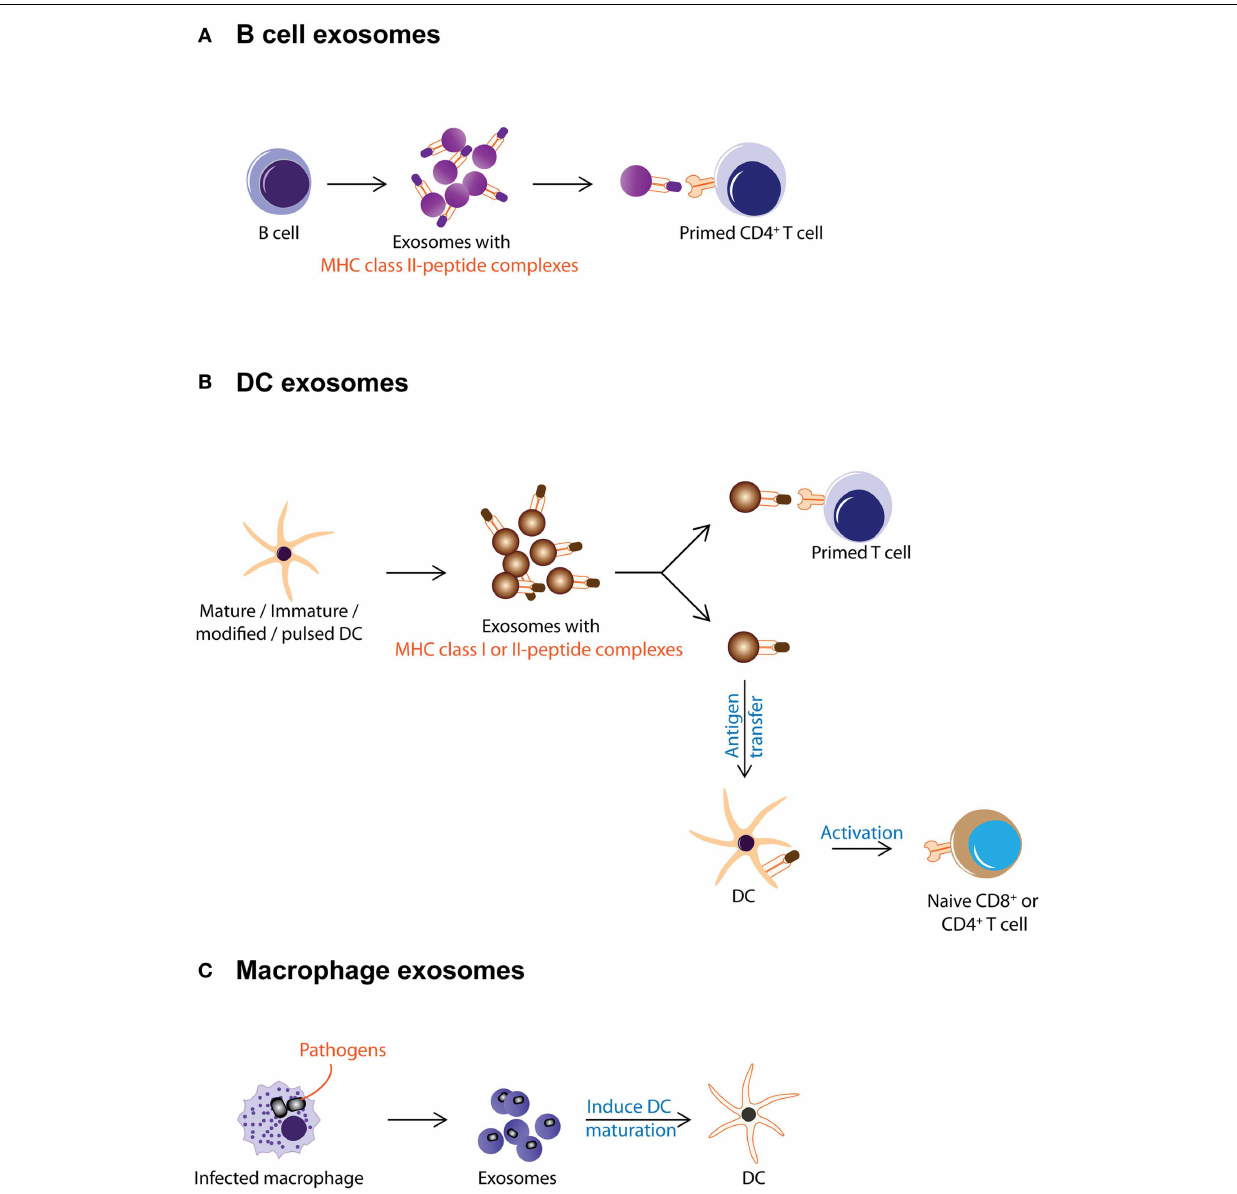
FIGURE 2 | Exosomes from immune cells are shown .This figure summarizes the different known activities of exosomes from immune cells. (A) B cell secretes exosomes carrying MHC class II–peptide complexes as a mode of antigen presentation to primed CD4 + T cell. (B) DC-derived exosomes carry MHC class I or II-peptide complexes that can be either